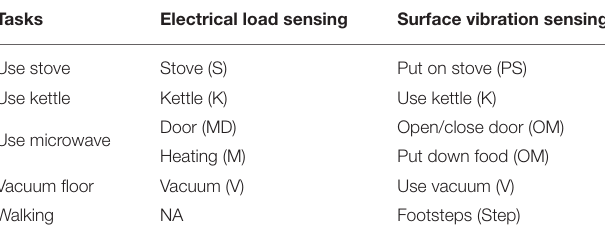
TABLE 2 | Target kitchen activities and their